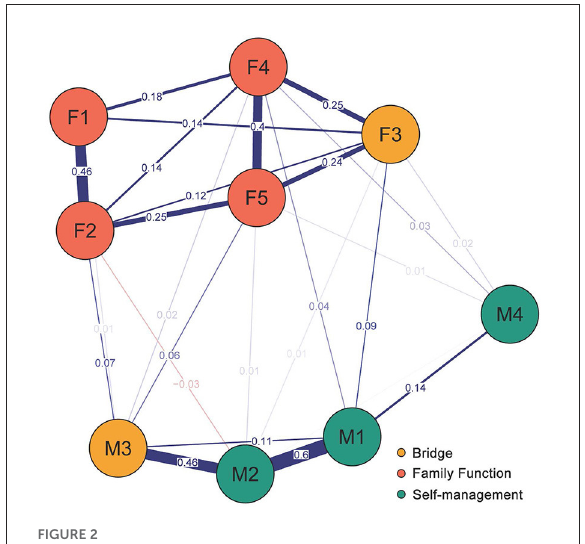
FIGURE2 Network structure of family function and self-management showing bridge components in patients with early